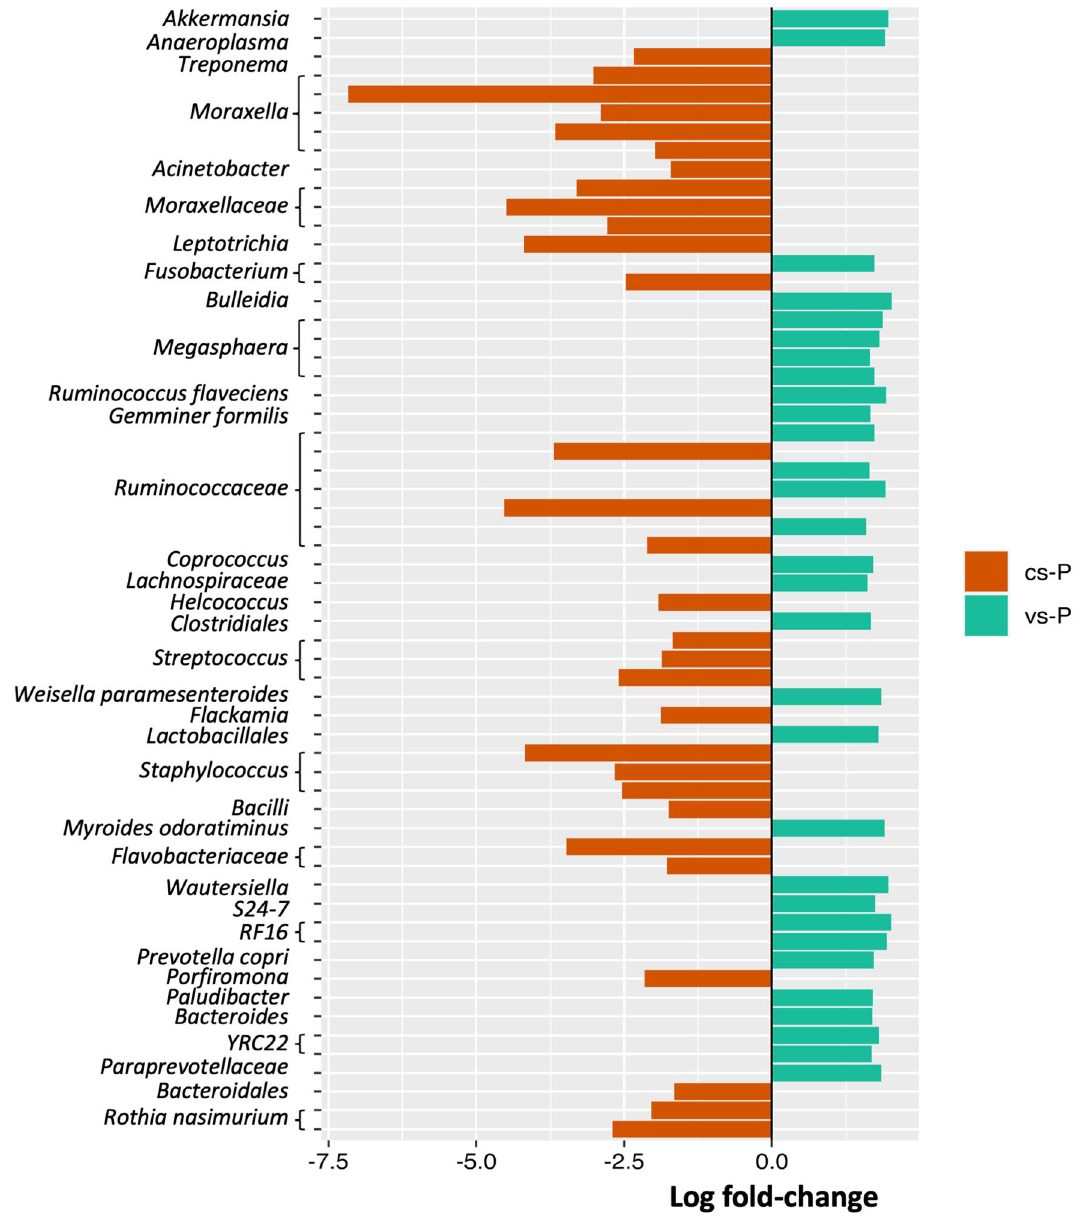
Figure 4. Differential abundant features between nasal microbiota composition of piglets from control (cs-P, orange bars) or vaccinated sows (vs-P, green bars). The association of the 30 features with the highest differential ranked coefficient estimated with q2-songbird is depicted (log